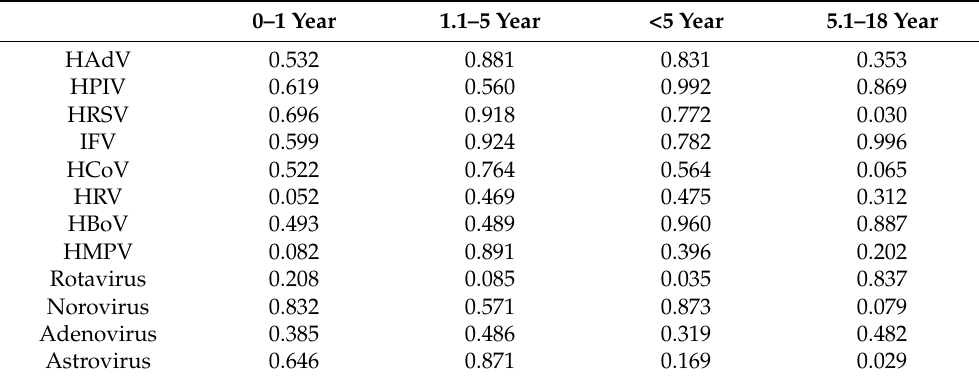
Table 2. Causality of immune thrombocytopenia (ITP) incidence after 1 month with virus.